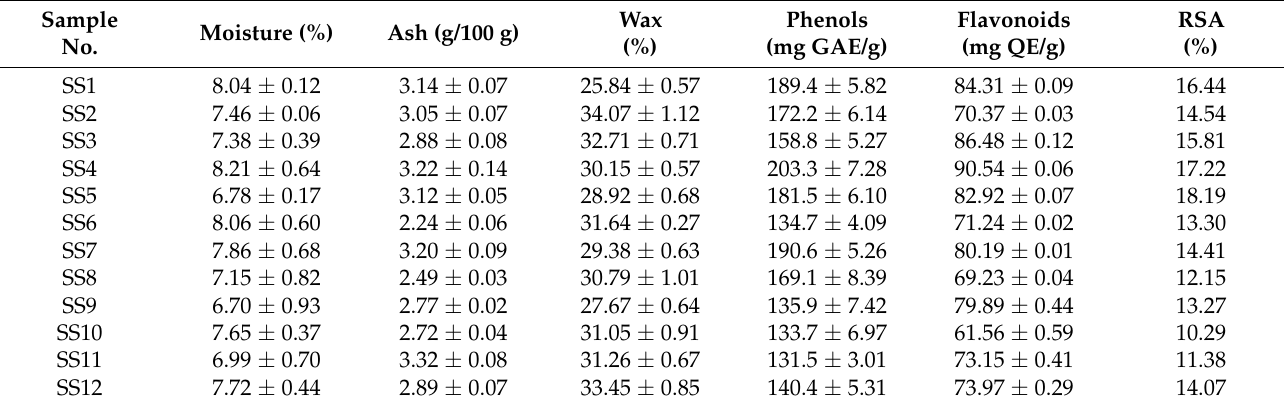
Table 6. Characterization of propolis samples from Alba